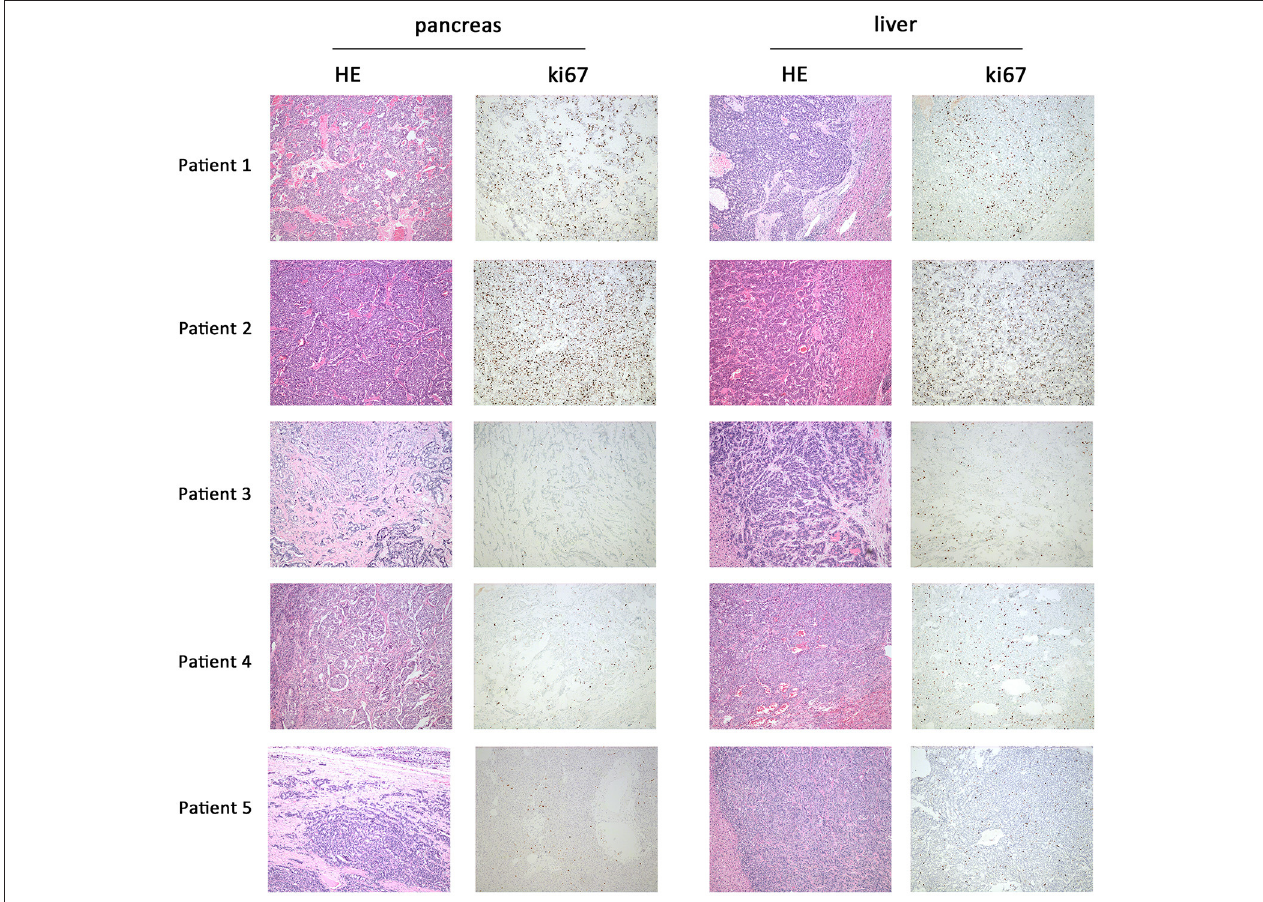
FIGURE 1 | Representative hematoxylin and eosin and immunohistochemistry against ki67 in primary and metastatic lesions. In patient 1 and patient 2, HE staining of primary (pancreas) and metastatic lesions (liver) showed a mitotic count > 20/10 HPF; the cells were poorly differentiated and composed of highly atypical